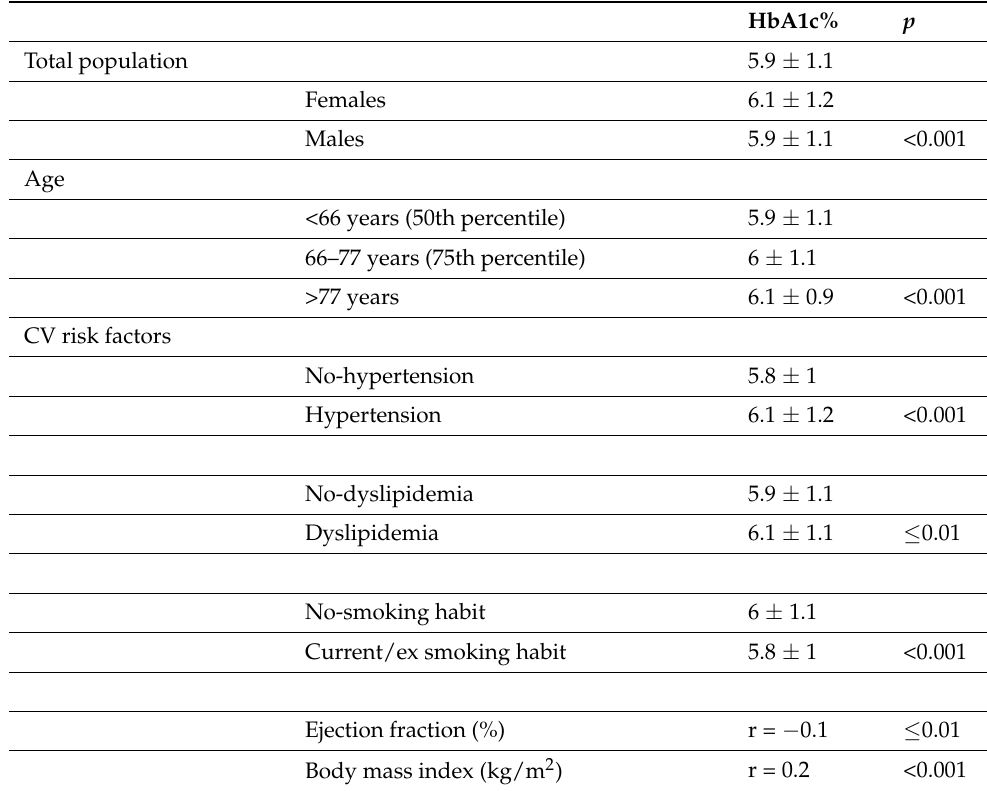
Table 2. Demographic, clinical, and laboratory parameters according to HbA1c values.